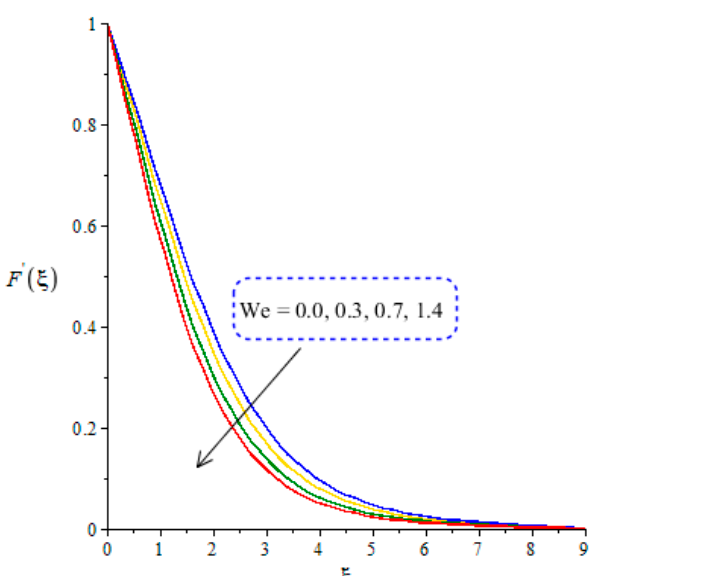
Figure 4. Variation role of F (cid:48) ( ξ ) versus We when m = 0.3, Ω = 3.0, M 2 = 0.3, β e = 0.5, β i = 0.7, Figure 4. Variation role of 𝐹′(𝜉) versus 𝑊𝑒 when 𝑚 = 0.3, Ω = 3.0, 𝑀 (cid:2870) = 0.3, 𝛽 (cid:3032) = 0.5,𝛽 (cid:3036) = (cid:101) = 0.01, F r = 3.5, Pr = 204, Ec = 3.0, ϕ 2 = 0.0075, ϕ 1 = 0.002, ϕ 3 = 0.005. 0.7, 𝜖 = 0.01, 𝐹 (cid:3045) = 3.5, 𝑃𝑟 = 204, 𝐸𝑐 = 3.0,𝜑 (cid:2870) = 0.0075, 𝜑 (cid:2869) = 0.002,𝜑 (cid:2871) = 0.005.